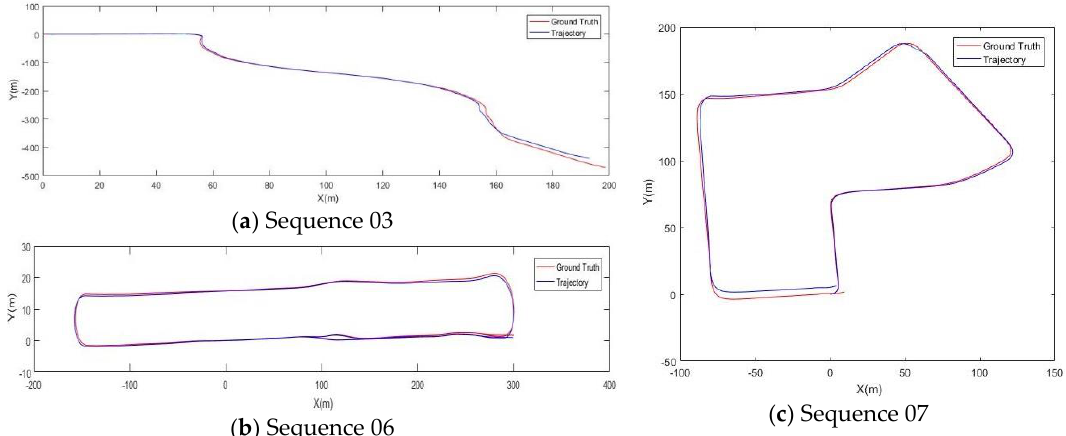
Figure 11. The trajectory produced by MIM_SLAM in the three sequences.